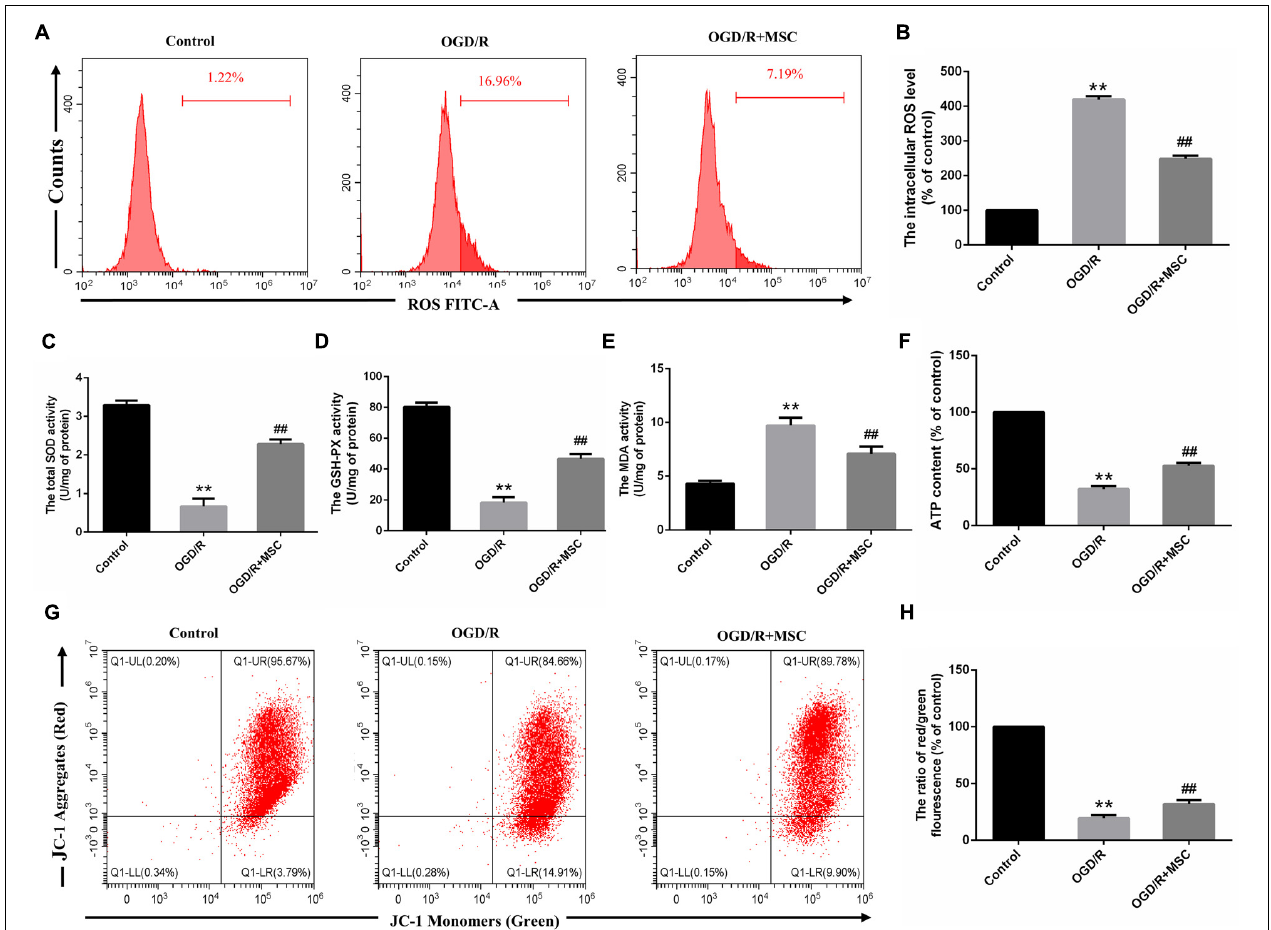
FIGURE 4 | OM-MSCs attenuated OGD/R-induced ROS overproduction and mitochondrial dysfunction in N 2 a cells. (A–B) Intracellular ROS levels in N 2 a were measured by staining with DCFH-DA, and the determination of ROS levels was carried out using a flow cytometer. (C–E) The total SOD, GSH-PX, and MDA activities in N 2 a were assessed. (F) The ATP content in N 2 a cells was assessed using an ATP assay kit, and data are expressed as a percentage of the control. (G,H) N 2 a was incubated with JC-1, and the determination of mitochondrial membrane potential was carried out using a flow cytometer. The mitochondrial membrane potential in each group was calculated as the ratio of red to green fluorescence. All data are displayed as mean ± SEM ( n = 3). ( ∗∗ P < 0.01 vs. control; ## P < 0.01 vs.